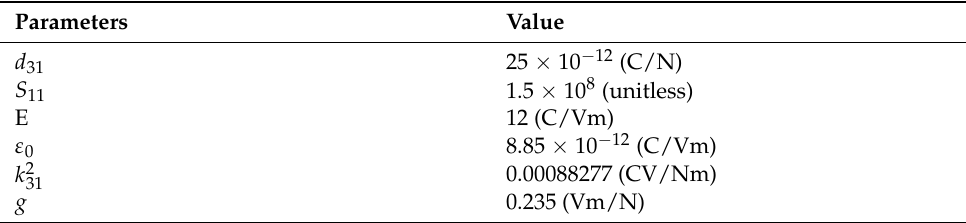
Table 1. The polyvinylidene fluoride (PVDF) piezoelectric parameters.